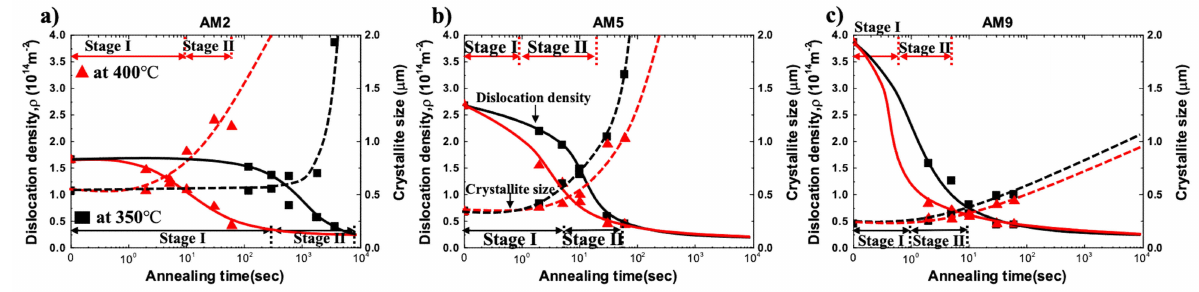
Figure 16. Evolution of the dislocation density and crystallite size as a function of annealing time at 350 ◦ C and 400 ◦ C in ( a ) AM2, ( b ) AM5, and ( c )